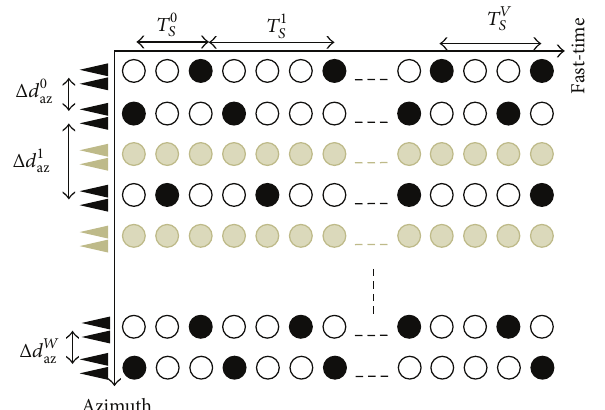
Figure 7: Sample selection scheme on full SAR data simulating a real CS sensor. Fast-time samples in white and azimuth measure- ments in grey are skipped.